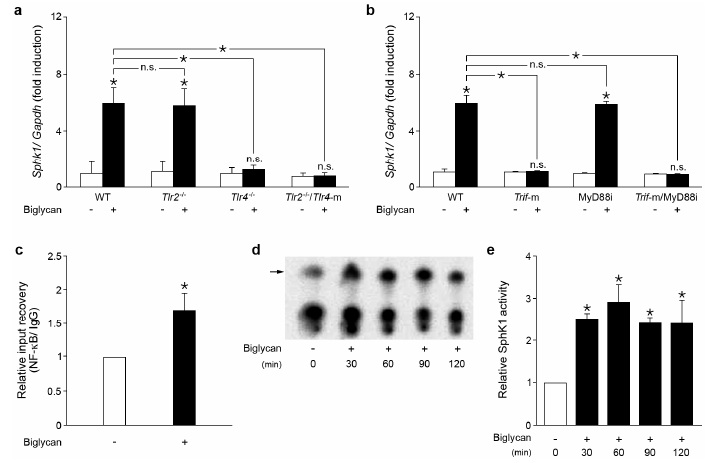
Figure 1. Biglycan triggers Sphk1 mRNA expression via TLR4/TRIF/NF- κ B and stimulates SphK1 activity in macrophages. ( a , b ) qPCR analysis of Sphk1 normalized to Gapdh mRNA levels in biglycan-stimulated (4 µ g/mL, 6 h): ( a ) WT, Tlr2 − / − , Tlr4 − / − and Tlr2 − / − /Tlr4 -m macrophages;